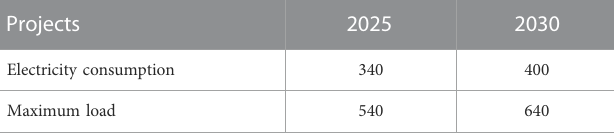
TABLE 1 Electricity demand of Yunnan in 2025 and 2030 (Unit: